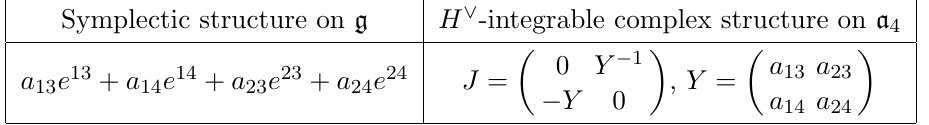
Table 1 . Correspondence of symplectic and H _ -integrable complex structures from example